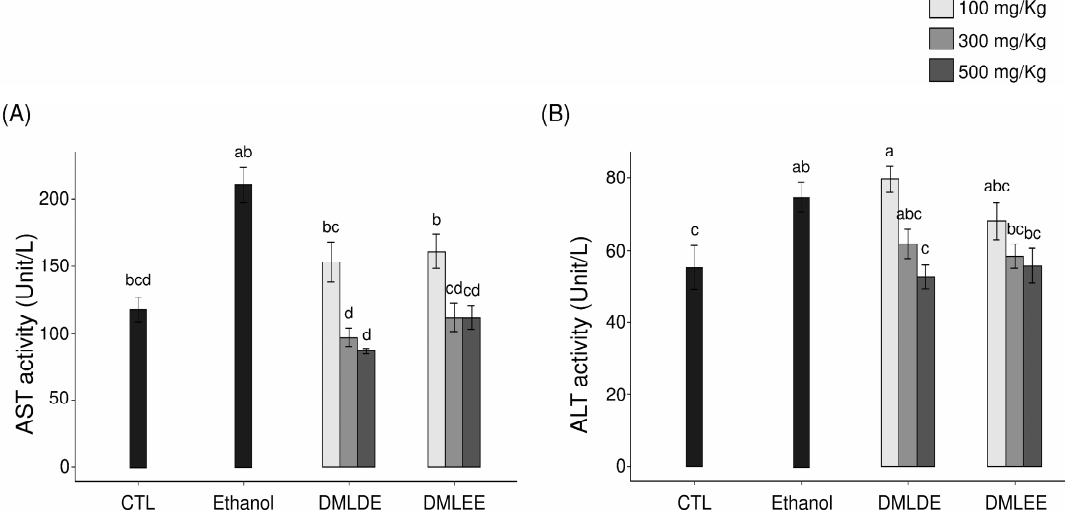
Figure 1. Effect of the Dendropanax morbifer leaf ethanol and D.W extracts on serum ALT and AST activities in alcohol-fed rat. ( A ) AST activity and ( B ) ALT activity. The data are expressed as the mean ± SD ( n = 6), and different letters indicate (a > b > c > d) a significant difference at p < 0.05, as determined by a Duncan’s multiple range test.